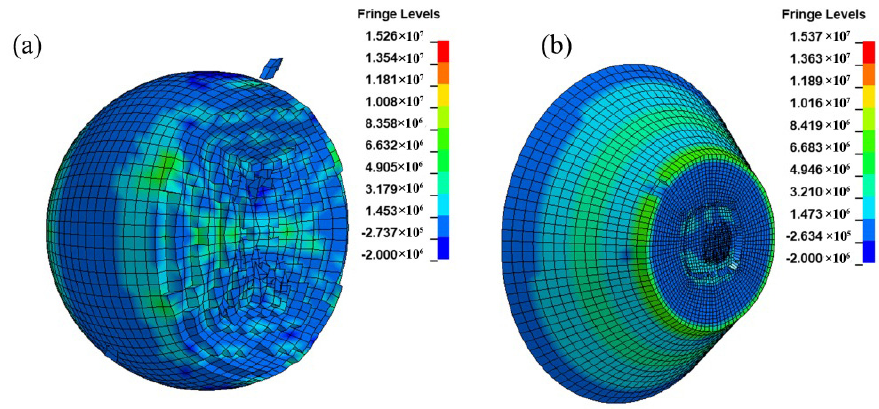
Figure 17. The Von Mises stress and damage to ice blocks at 0.5 s: ( a ) Sphere; ( b ) Truncated cone.